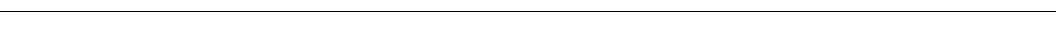
Figure 1 | CLOuD9 induces reversible b -globin promoter-LCR looping. ( a ) Addition of abscisic acid (ABA, green) brings two complementary CLOuD9 constructs (CLOuD9 S. pyogenes (CSP), CLOuD9 S. aureus (CSA), red and blue, respectively) into proximity, remodelling chromatin structure. Removal of ABA restores the endogenous chromatin conformation. ( b ) CLOuD9 constructs combine CRISPR-dCas9 technology from S. aureus and S. pyogenes with reversibly dimerizeable PYL1 and ABI1 domains. ( c ) Timeline of CLOuD9 dimerization experiments. ( d ) 3C assay measuring b -globin locus-wide crosslinking frequencies in K562 cells after 24h of treatment with ABA (red) and subsequent washout (blue) showing reversibility of induced b -globin/LCR contacts (highlighted in grey). Orange arrowheads indicate specific CLOuD9 construct target regions. The EcoRI fragment containing hypersensitivity sites 1–4 of the LCR (black bar) was used as the anchor region. Its crosslinking frequency with other indicated EcoRI fragments (names on the top of the graph) were assessed. The human b -globin genes and LCR hypersensitivity sites are depicted on the bottom of the graph with chromosomal position coordinates. Data from ChIP-seq of H3K4me3 and H3K9me3 demonstrate that this region is euchromatic in K562s. ( e ) Similar reversible changes in chromatin structure are seen in HEK 293Tcells, despite evidence from H3K4me3 and H3K9me3 ChIP-seq data that the globin region is heterochromatic in this cell type. ( f ) 3C assay measuring Oct4 locus-wide crosslinking frequencies in 293Tcells after 72h of treatment with ABA (red) showing induced Oct4/distal enhancer contacts (highlighted in grey). Orange arrowheads indicate specific CLOuD9 construct target regions. The MboI fragment containing the Oct4 promoter (black bar) was used as the anchor region. Its crosslinking frequency with other indicated MboI fragments (names on the top of the graph) were assessed. The human Oct4 regions are depicted on the bottom of the graph with chromosomal position coordinates. All of the 3C results were obtained from at least three independent experiments. 3C values were normalized to tubulin. For b -globin, interaction frequencies between the anchor fragment and the fragment encompassing the b /HS fragment were set to zero. For Oct4, interaction frequencies between the anchor fragment and a negative control fragment outside of the Oct4 interacting region were set to zero. Error bars indicate s.d. n ¼